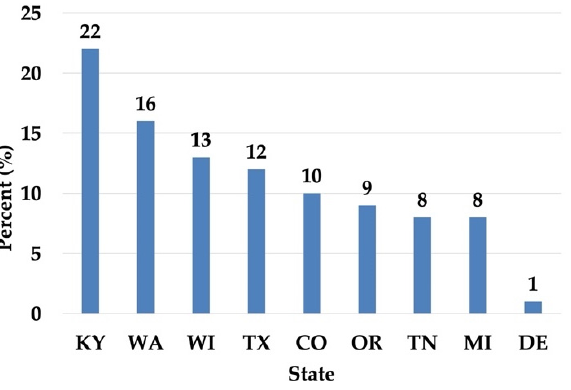
Figure 2. Percent (%) of 2018 Animal Cruelty Incidents and Co-Occurring Offenses by State.